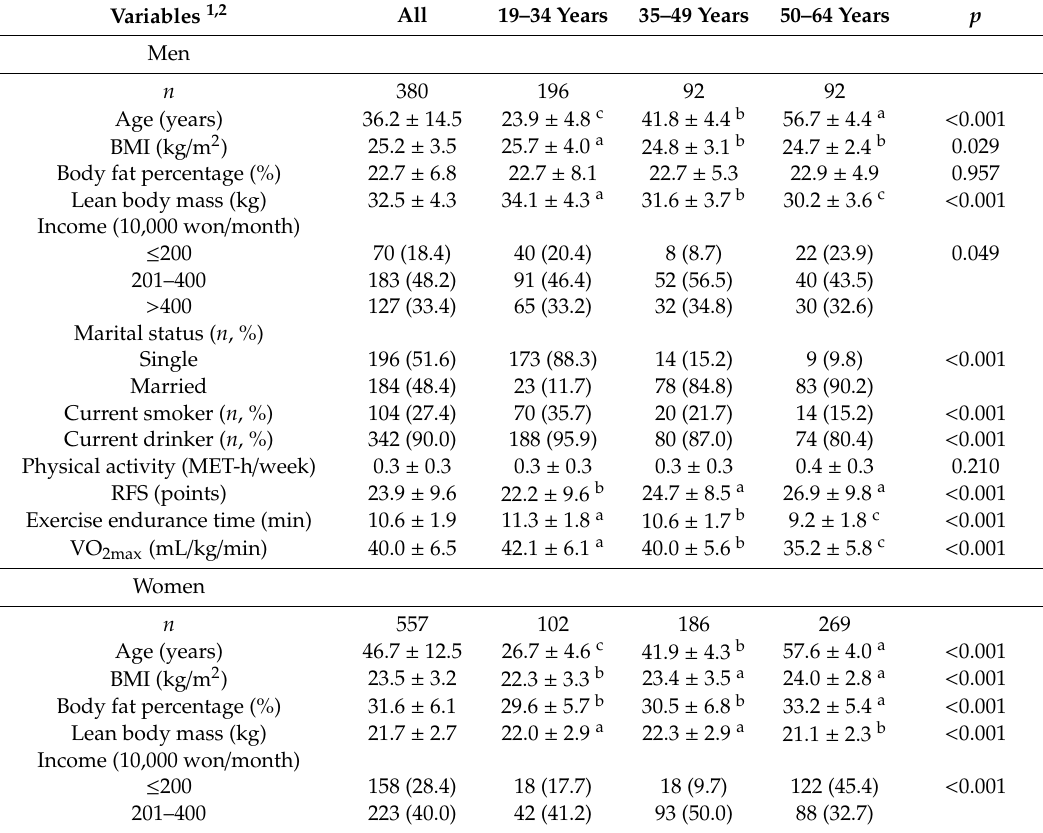
Table 1. General characteristics of study participants according to age and